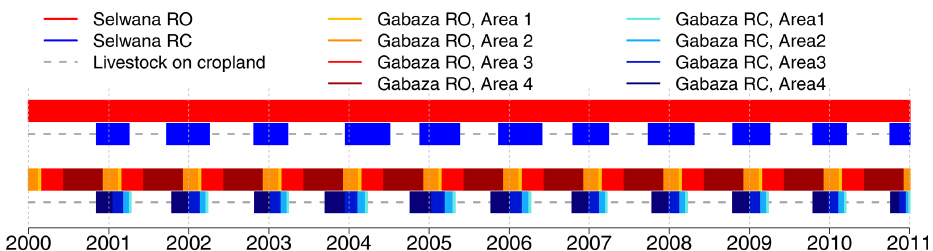
Figure 2. Periods of livestock presence on communal rangeland. Bars with a red hue illustrate periods of rangeland presence in the RO scenario, bars with a blue hue show the rangeland presence/crop growth period in the RC and SQ scenarios, and dashed gray lines indicate animal presence on cropland. For Gabaza (bottom pair of bar sequences), the different hues show animal presence in the four sub-areas. The period of animal presence in sub-areas is proportional to the sub-area